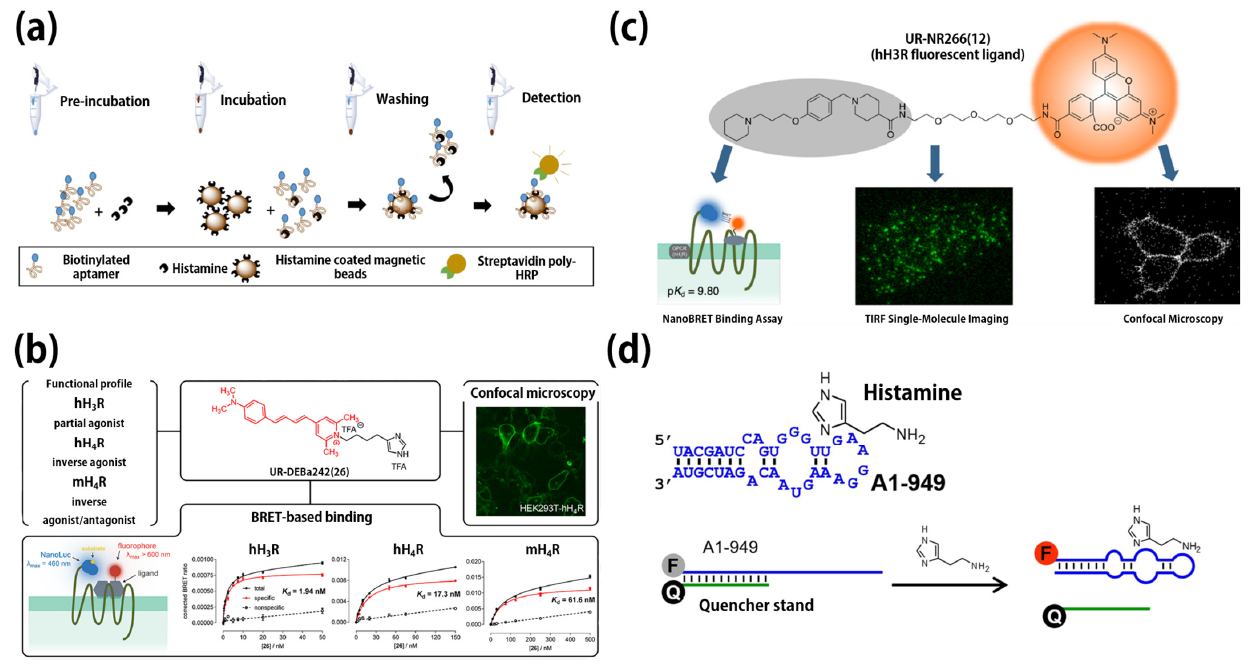
Figure 3. ( a ) Schematic representation of the detection of histamine using a competitive assay